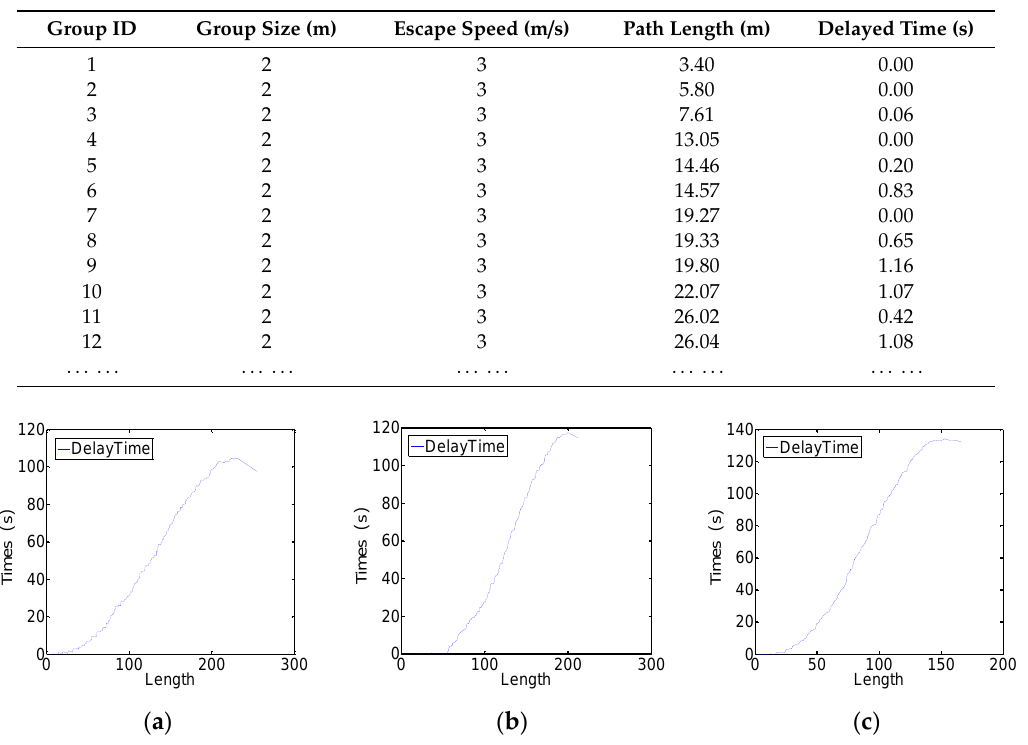
Table 5. The relationship of the evacuation path length and the delayed departure time of some groups planned by the PSEP algorithm when evacuation density is low Group ID